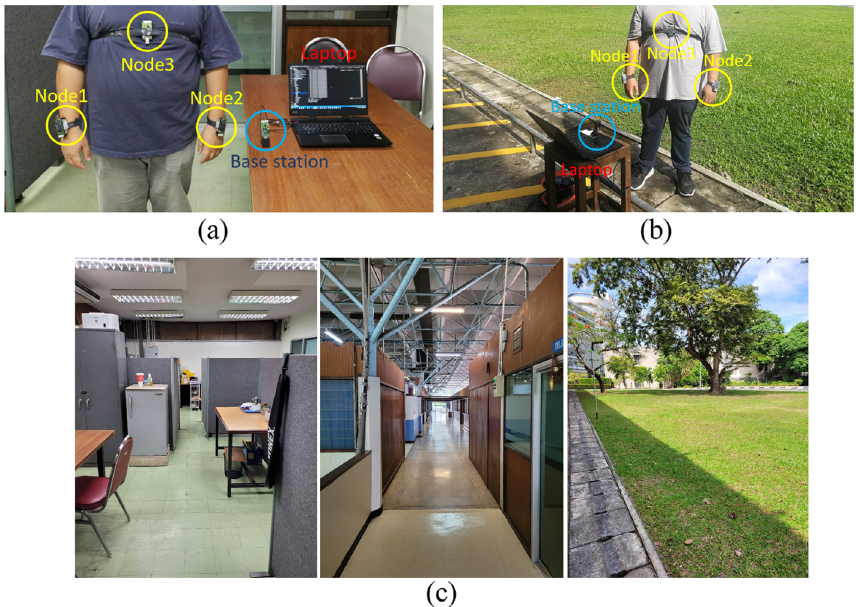
Fig. 6 Test case #3, changing the environments; a the man stands in the room, b the man stands on the ground outside the building, and c room, building, and outdoor environments